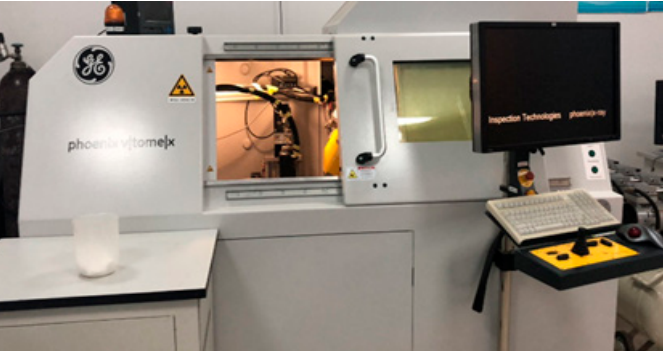
Figure 1. The integrated equipment (CT combined with triaxial apparatus). This is the overall image of the equipment. In the central window is the triaxial apparatus. The controlling and data collection system are located at right side.